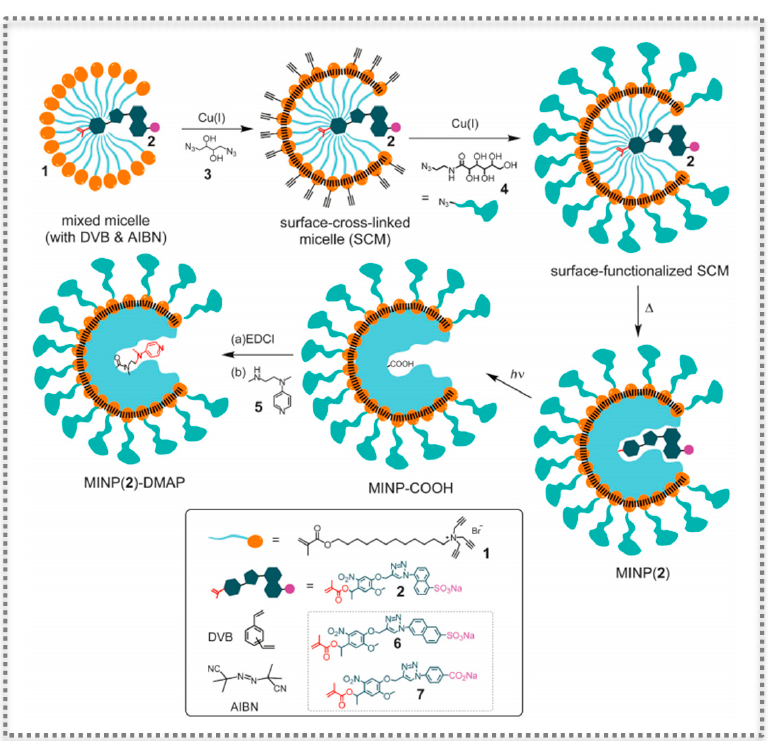
Figure 8. Preparation of catalytic molecularly imprinted nanoparticles (MINPs) functionalized with the transacylation catalyst 4-dimethylaminopyridine (DMAP), as a method to molecularly imprint within cross-linked micelles. (Reproduced with permission [79], Copyright 2017, Wiley-VHCA AG).